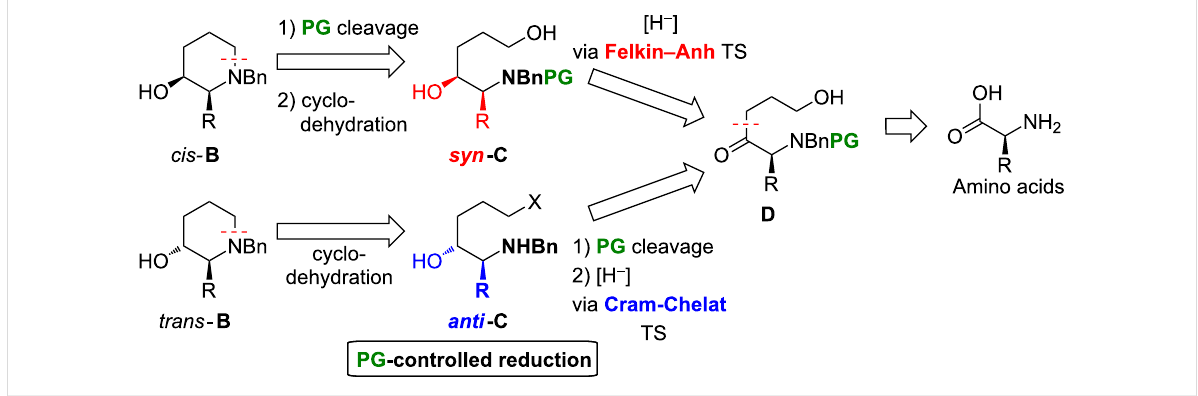
Figure 2: Retrosynthetic analysis of piperidines B (X = OH or leaving group, PG = protecting group).